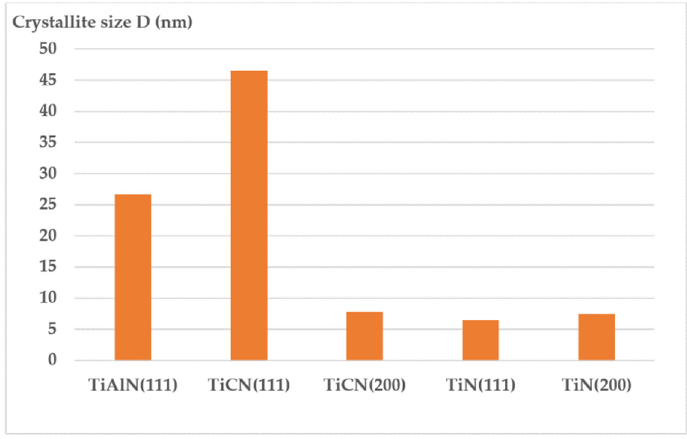
Figure 7. The crystallite size of the TiN, TiAlN and TiCN